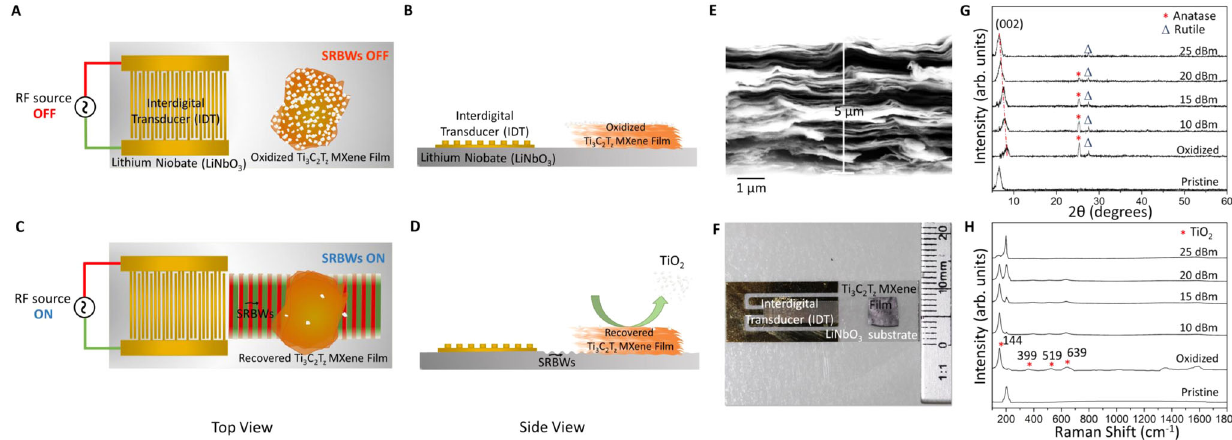
Fig. 1 | Experimentalsetup andmaterialscharacterization. A , C Top, and,( B , D ) side view schematics of the experimental setup in which a 5 µ m thick oxidized Ti 3 C 2 T z MXene fi lm (a scanning electron microscopy (SEM) image of which is shown in ( E )) is placed atop the surface re fl ected bulk wave (SRBW) resonator, whichcomprisesachipscalesingle-crystalLiNBO 3 piezoelectricsubstrate,shownin ( F ).In( C , D ),theSRBW — generated byapplying asinusoidalelectricalsignalfroma